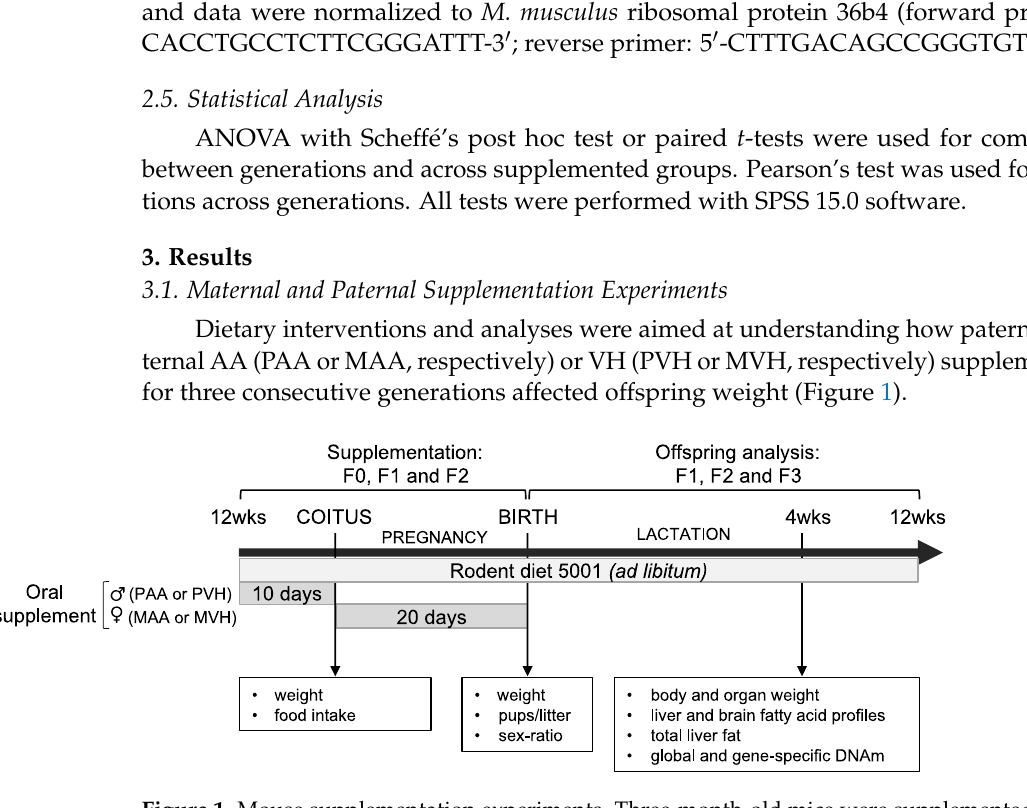
Figure 1. Mouse supplementation experiments. Three-month-old mice were supplemented with AA dissolved in vehicle (VH; soybean oil), or VH only, maternally (MAA and MVH) or paternally (PAA and PVH, respectively) for three consecutive generations (F0, F1, and F2). Administration of AA and VH supplements were performed within similar time frames. The effect of either FA supplement was subsequently analyzed in one-month-old F1, F2, and F3 offspring of AA- or VH-exposed dams or sires.